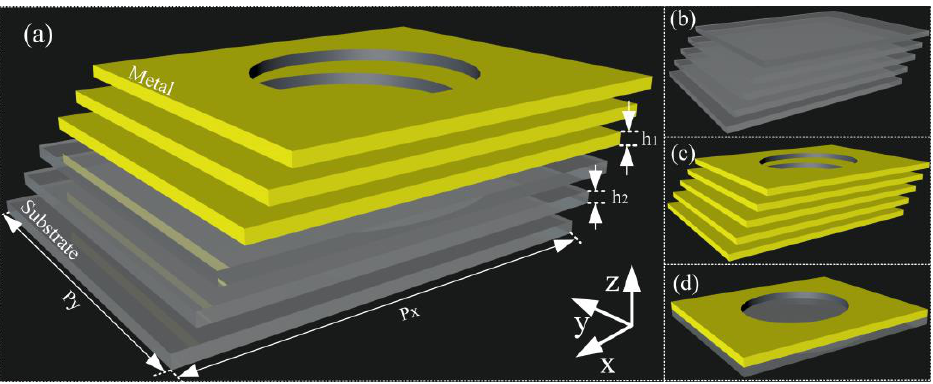
Figure 1. Unit structure diagram and structure diagram under different cascading conditions. ( a ) Multiple layers of different materials; ( b ) Single transparent material; ( c ) Single metallic materials; ( d ) Single-layer metal materials and transparent materials.